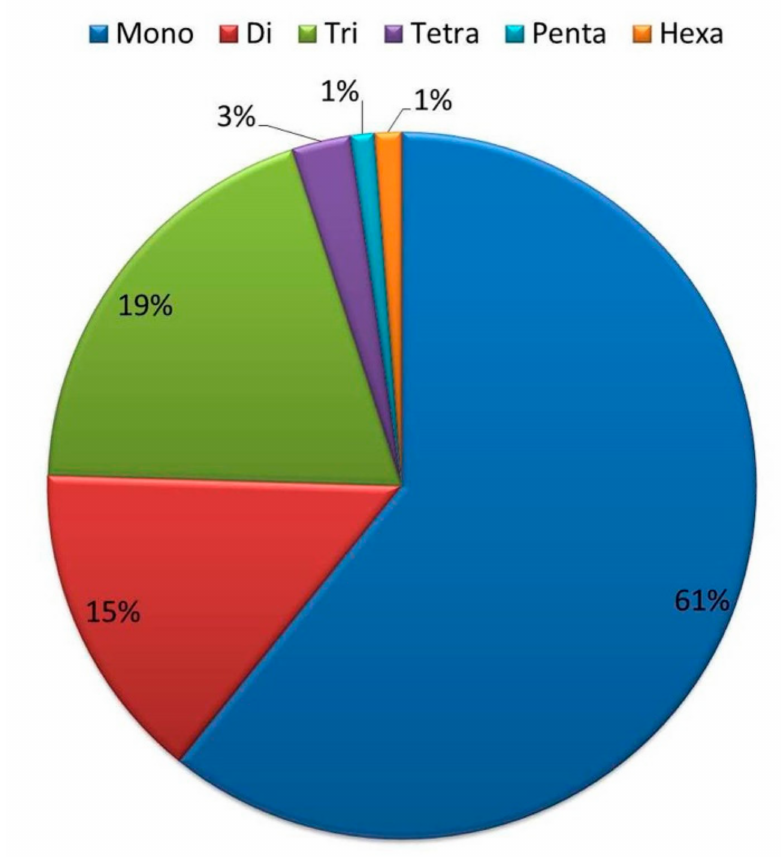
Figure 2. Percentage distribution of the simple sequence repeats (SSR) motif